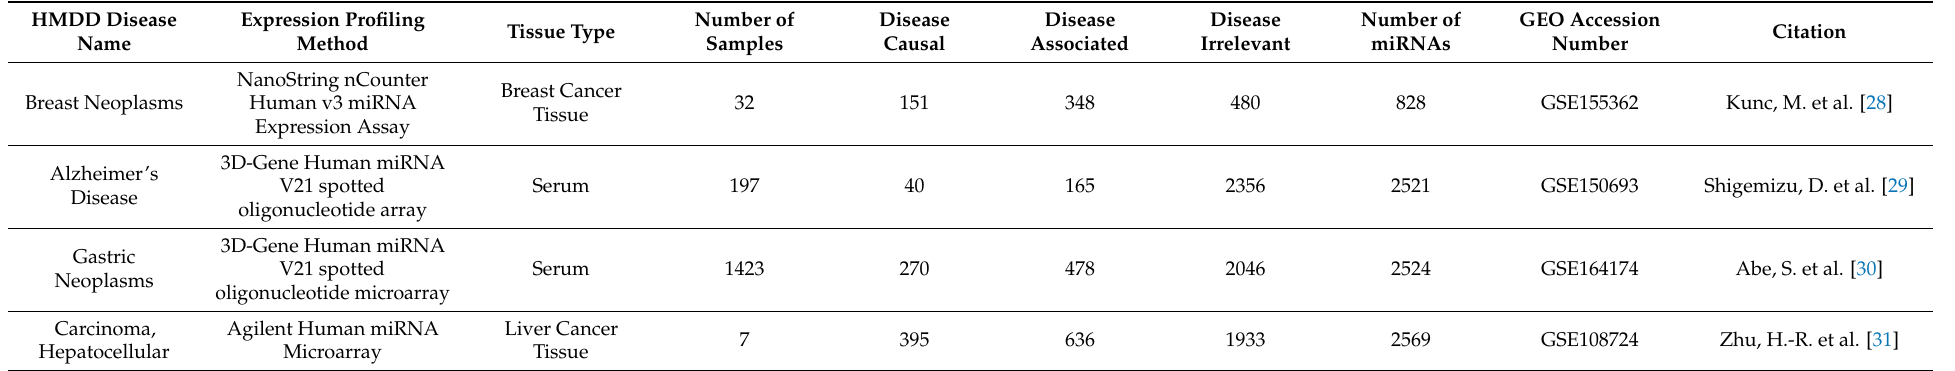
Table 1. Disease Dataset